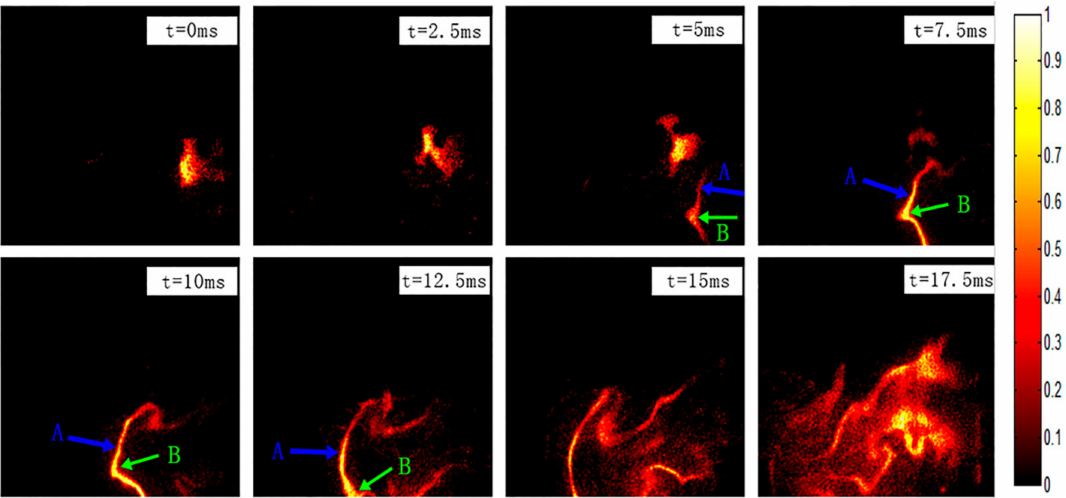
Figure 2. Flame evolution following spark ignition, field of view = 110 mm × 110 mm. Frame rate = 400 Hz. A and B mean flame surface and wrinkled structure, respectively. The oxygen concentration is 33%. The excess air coefficient α = 1.652, which is the ratio of the practical oxygen supply to the theoretical oxygen consumption. The oxygen consumption is 103 L/min, and the total gas flow is 676 L/min.